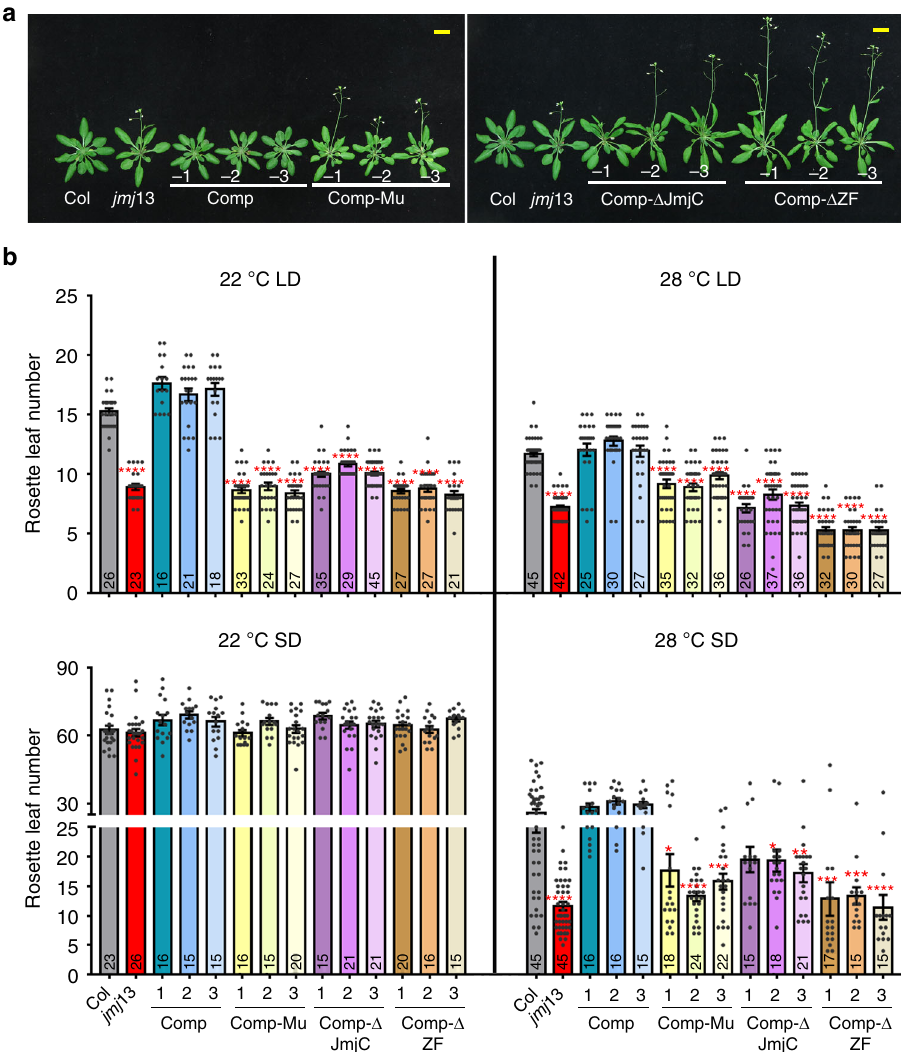
Fig. 5 JMJ13 negatively modulates fl owering time in a temperature- and photoperiod-dependent manner. a Three complementary lines Comp − 1, − 2 and − 3 (p JMJ13 : JMJ13 -HA jmj13 ) showed similar fl owering time with wild type in 22 °C LD conditions, but the complementary lines Comp-Mu − 1, − 2 and − 3 with site mutation in the two conserved iron-binding amino acids (p JMJ13 : JMJ13mu -HA jmj13 ), the complementary lines with truncation in JmjC Comp- Δ Jmjc − 1, − 2, − 3 ( pJMJ13 : JMJ13 - Δ Jmjc - HAjmj13 ) and zinc fi nger domain Comp- Δ ZF − 1, − 2, − 3 ( pJMJ13 : JMJ13 - Δ ZF - HAjmj13 ) remain early fl owering. The plant images were created by the authors in this research. b The fl owering time of complementary lines (Comp − 1, − 2, − 3); (Comp-Mu − 1, − 2, − 3); (Comp- Δ Jmjc − 1, − 2, − 3); (Comp- Δ ZF 1, − 2, − 3) were assessed by counting rosette leaf numbers in bolting seedlings grown under 22 °C, 28 °C LD, and 22 °C, 28 °C SD conditions. Values are means ± SE of indicated number of plants for three independent biological repeats. N number was marked in the bottom of the column. Student ’ s t tests was used to calculate the P value between Col and other lines. **** P value < 0.0001; *** P < 0.001; ** P < 0.01; * P value < 0.05; Bar = 1 cm. The individual data points are shown as dots. Source data are provided as a Source Data fi